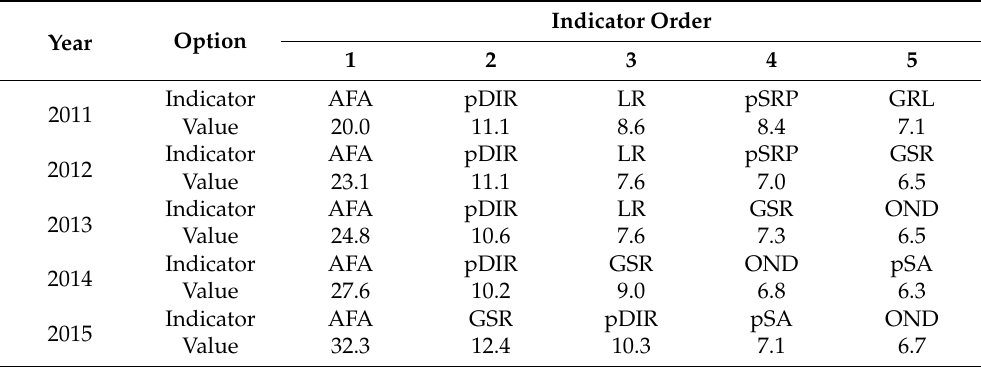
Table 2. Top five obstacle indicators of China’s food security during